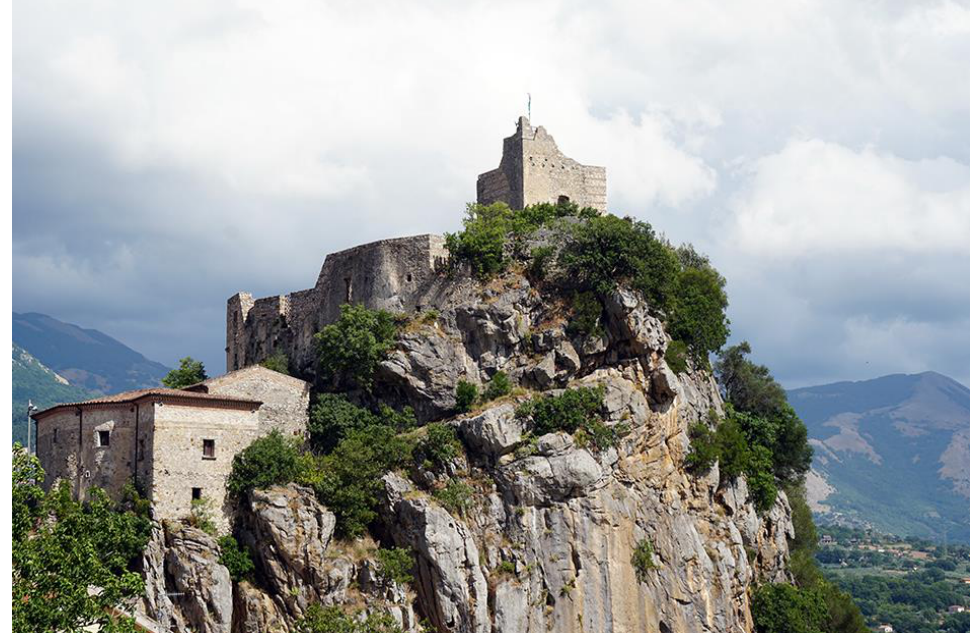
Figure 50. Calabritto: “Largo 23 November 1980”—Memorial dedicated to the earthquake victims (photos by [35,36]).